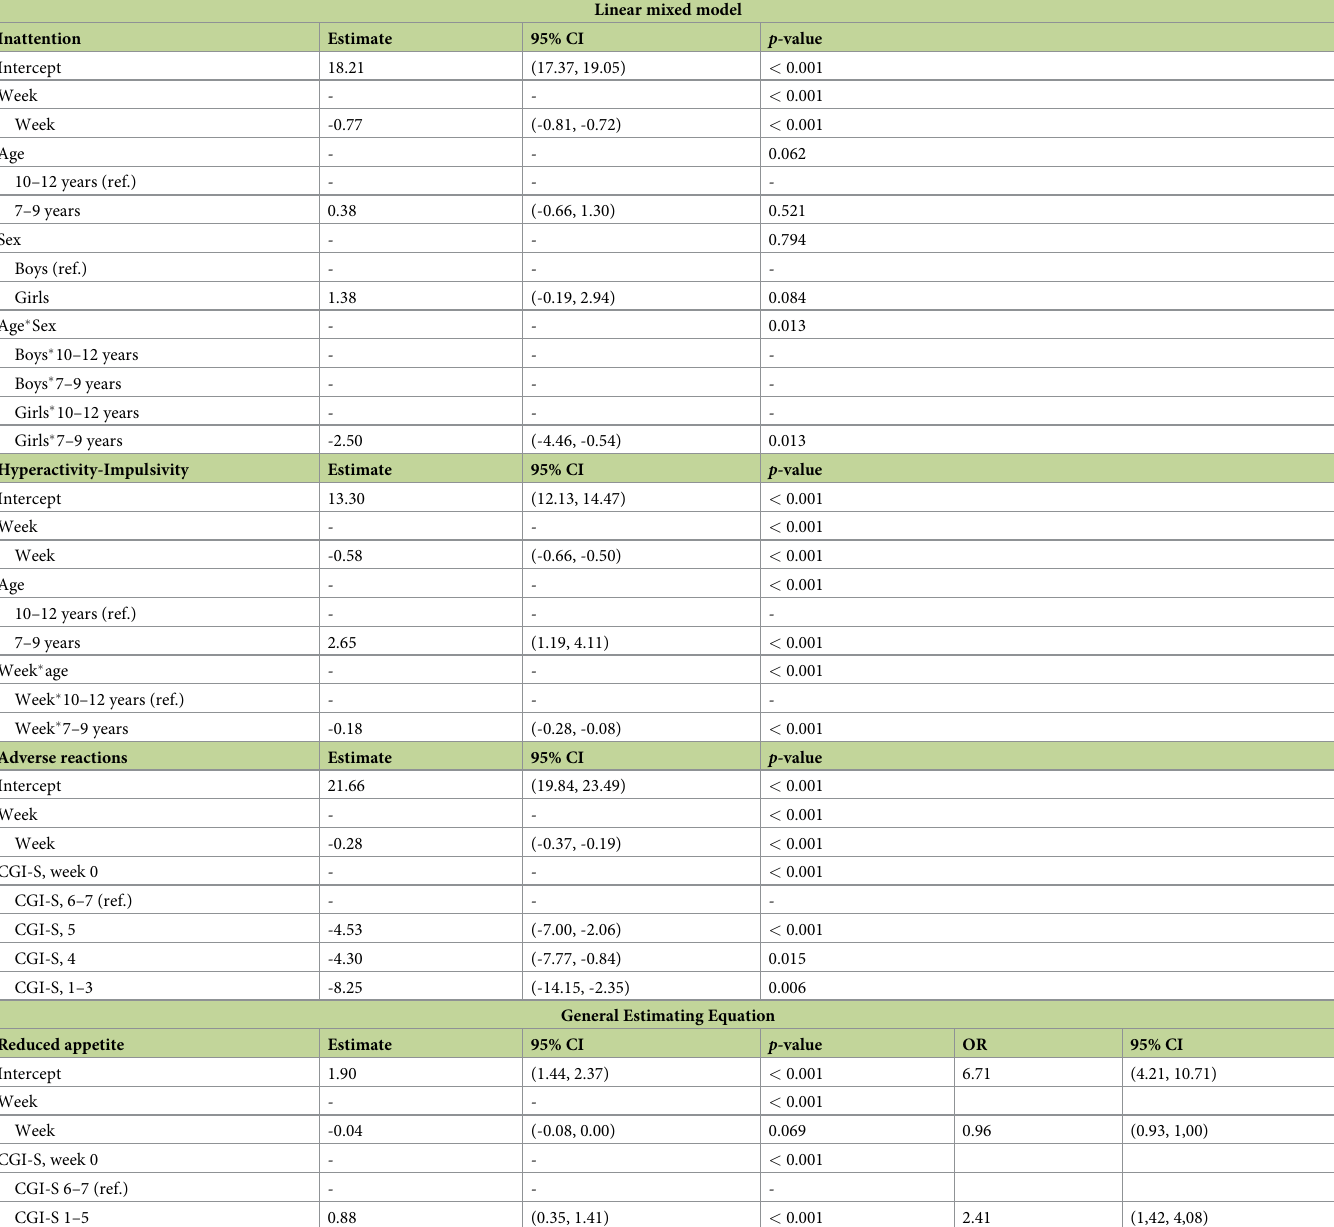
Table 3. Baseline characteristics as predictors for symptom reductions and adverse reactions ( n = 207).